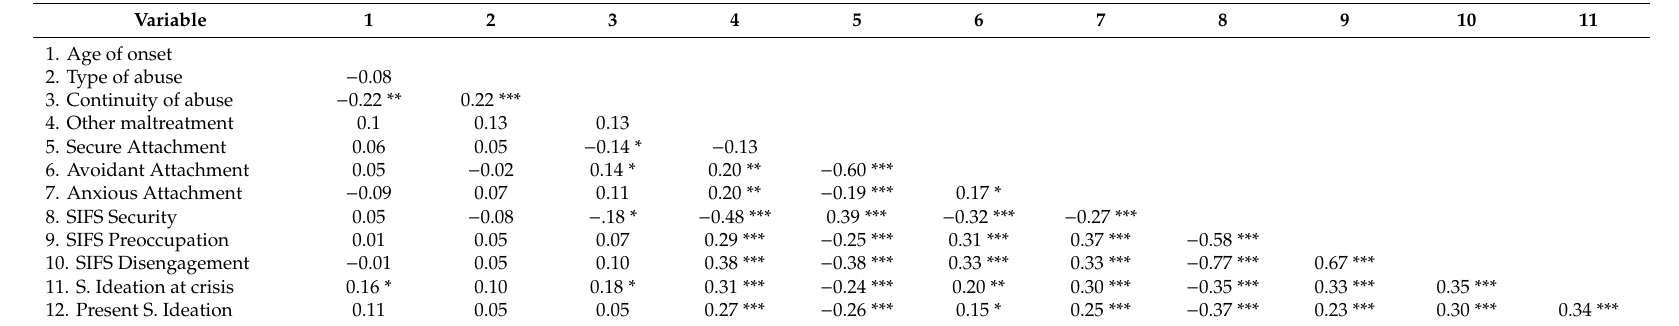
Table 4. Pearson correlations of all of the variables examined among CSA survivors ( n = 188)